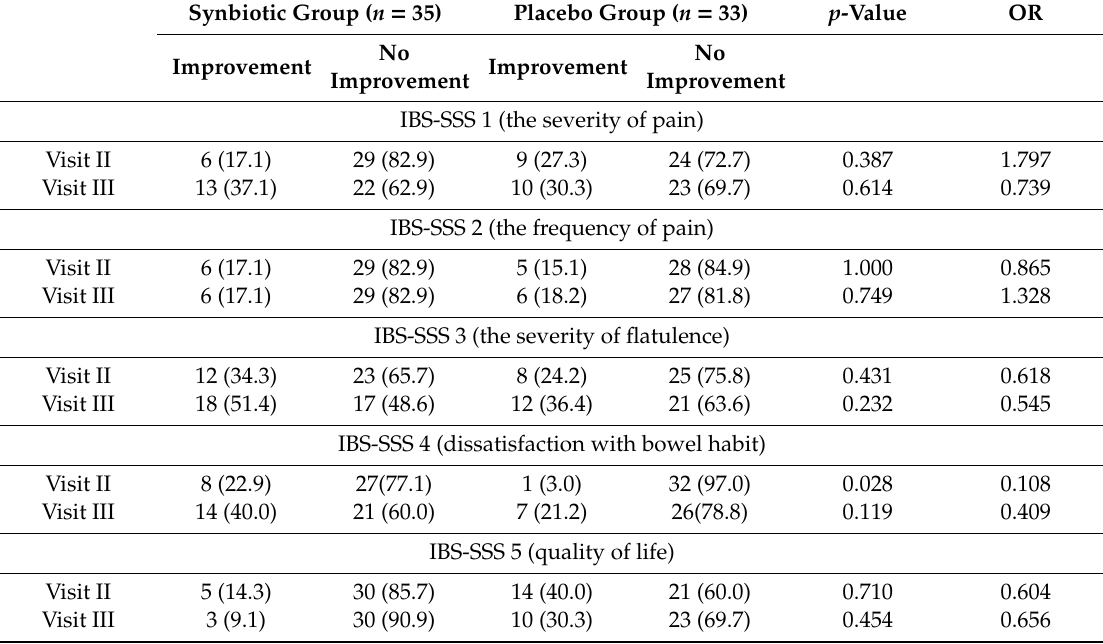
Table A1. The e ff ect of synbiotic treatment on the improvement of IBS severity assessed with the use of IBS-SSS score.